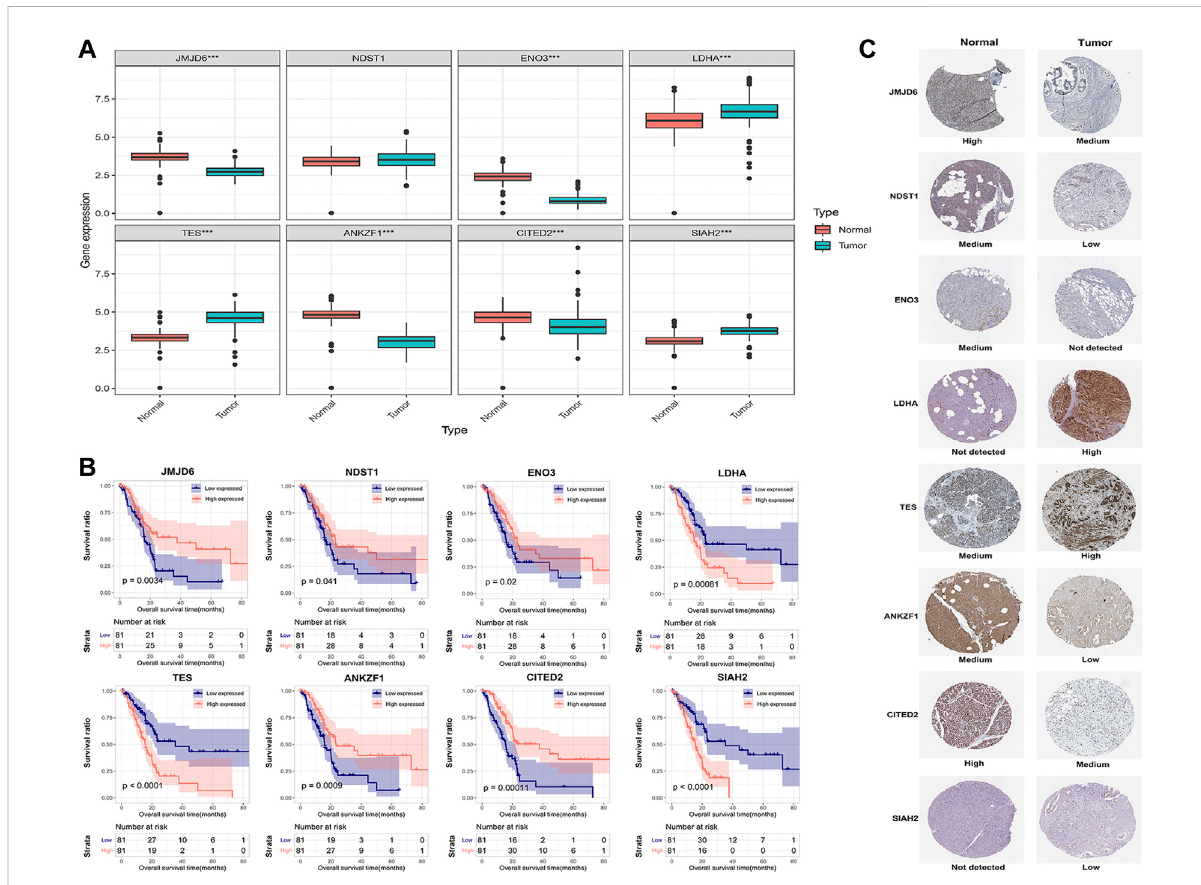
FIGURE 5 Validation of the expression of the eight signature genes in PAAD. (A) The mRNA expression pro fi le of the eight genes in tumor tissues from the TCGA database and normal pancreatic tissues from the TCGA and GTEx databases. (B) Kaplan-Meier curve of the association between the mRNA expression levels of the eight genes and the OS of PAAD patients. (C) The protein expression of the eight genes in pancreatic tumor tissues and normal tissues. The data were obtained from the HPA database. ENO3 was not found in the